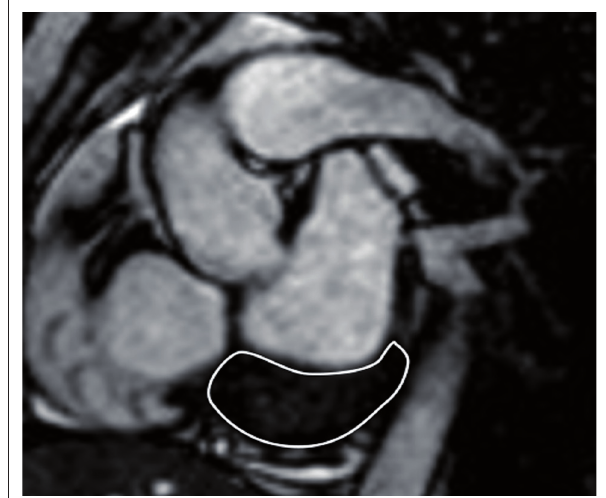
FIGURE 6: Single short-axis cine SSFP image of the basal LV myocardium. If only a small portion of the LV myocardium is evident in the most basal slice with no discernible LV blood pool, then only the epicardial border is contoured for the LV mass assessment.